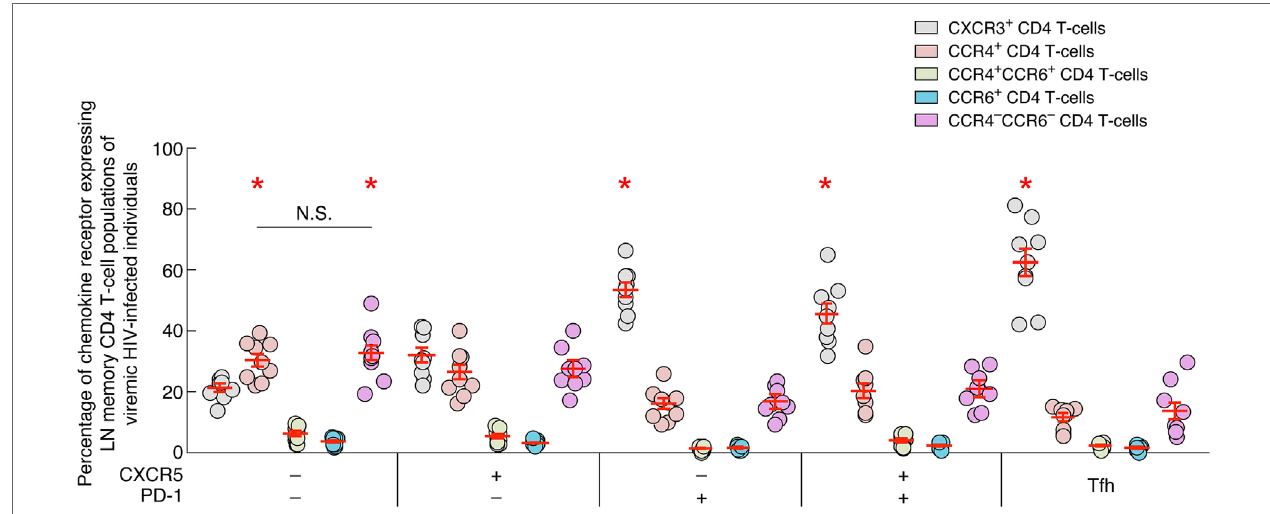
FigUre 7 | Chemokine receptor expression on lymph node memory CD4 T cell populations of viremic HIV-infected individuals. Percentage of chemokine receptor expression on lymph nodes (LNs) CD4 T-cell populations of viremic HIV-infected individuals ( N = 9). Red bars correspond mean ± SEM. CD4 T-cell populations were color coded. Red stars indicate statistical significance ( P < 0.05). Statistical significance ( P -values) was either obtained using one-way ANOVA (Kruskal–Wallis test) followed by Wilcoxon matched-pairs two-tailed signed rank